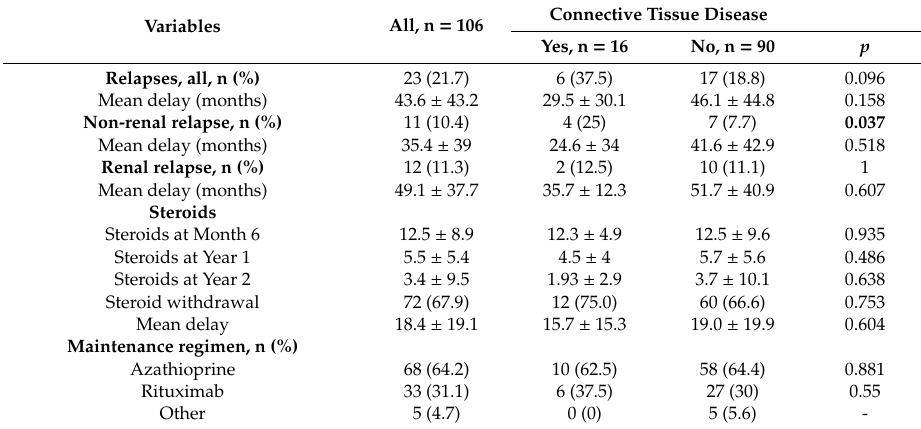
Table 5. Characteristics of relapses and maintenance regimen according to groups. Significant p-values appear in